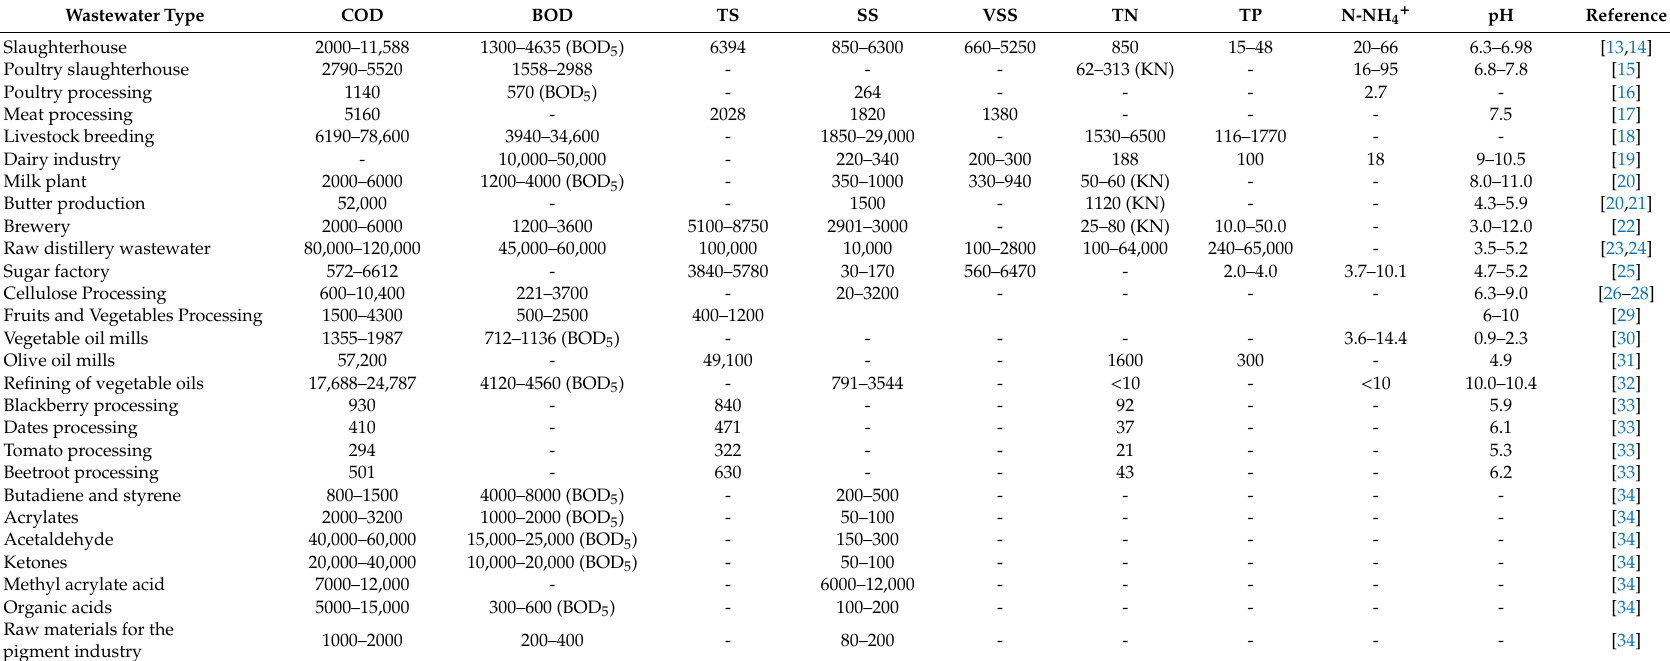
Table 4. Composition characteristics of individual industrial wastewaters (values are given in mg / L except